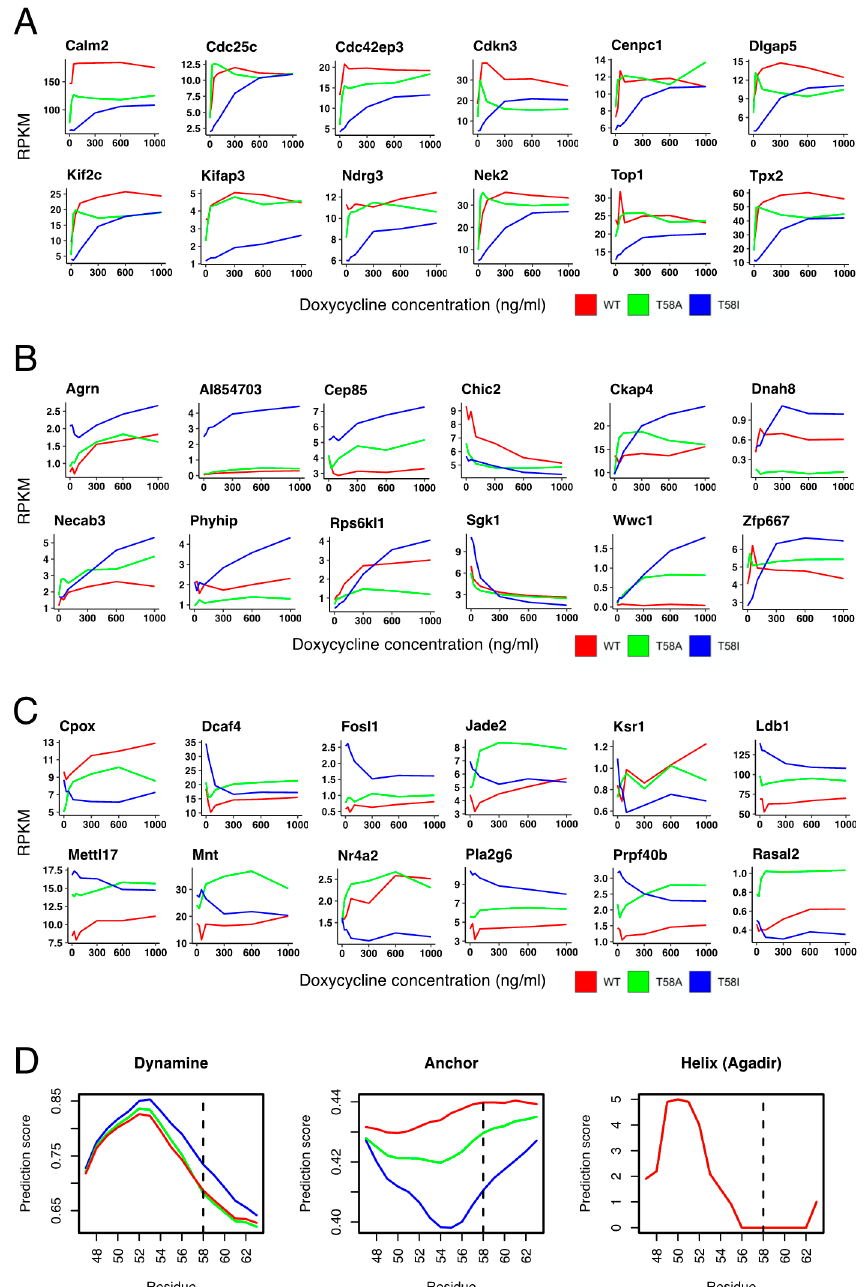
Figure 8. Genes that are differentially regulated by T58I MYC. ( A ) Plots showing the expression levels (RPKM) as a function of doxycycline concentration (0, 25, 50, 100, 300, 600 and 1000 ng/mL) for WT MYC (red), T58A MYC (green) and T58I MYC (blue). ( A ) Representative genes that show lower regulation by T58I MYC than WT MYC and/or T58A MYC. ( B ) Representative genes that show higher regulation by T58I MYC than WT MYC and/or T58A MYC. ( C ) Representative genes that show a different regulation direction by T58I MYC than WT MYC and/or T58A MYC. ( D ) Protein conformation predictions for the conserved MYC-Box I region, containing residue 58 (dashed line), in WT MYC (red), T58A MYC (green) and T58I MYC (blue). Dynamine predicts rigidity of the protein backbone (scale 0–1, where 1 is highly rigid). Anchor predicts protein interaction propensity (scale 0–1, where 1 is the highest propensity level). Helix (Agadir) is a prediction of alpha-helicity using the Agadir algorithm (the results are essentially identical for the three proteins, explaining the existence of only one visible plotted line).